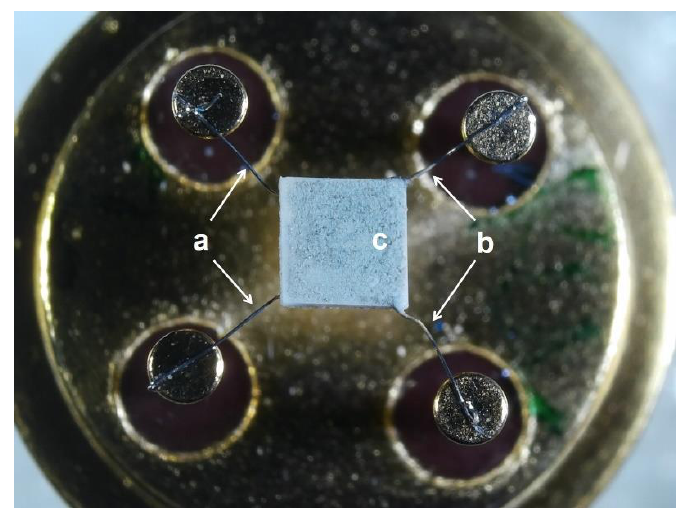
Figure 1. Microelectronic chip with: ( a ) platinum measuring contacts; ( b ) platinum heating contacts and ( c ) active layer of SnO 2 /SiO 2 on the Al 2 O 3 substrate.